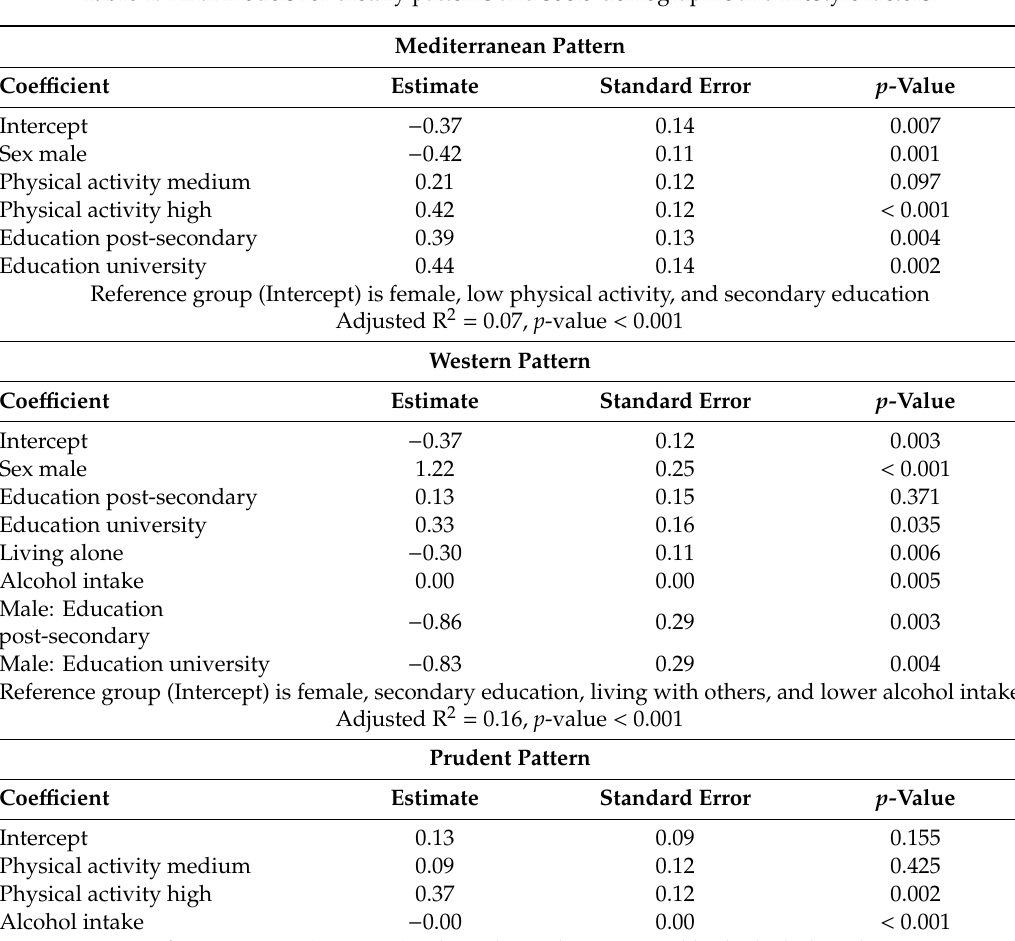
Table 4. Final models for dietary patterns and socio-demographic and lifestyle